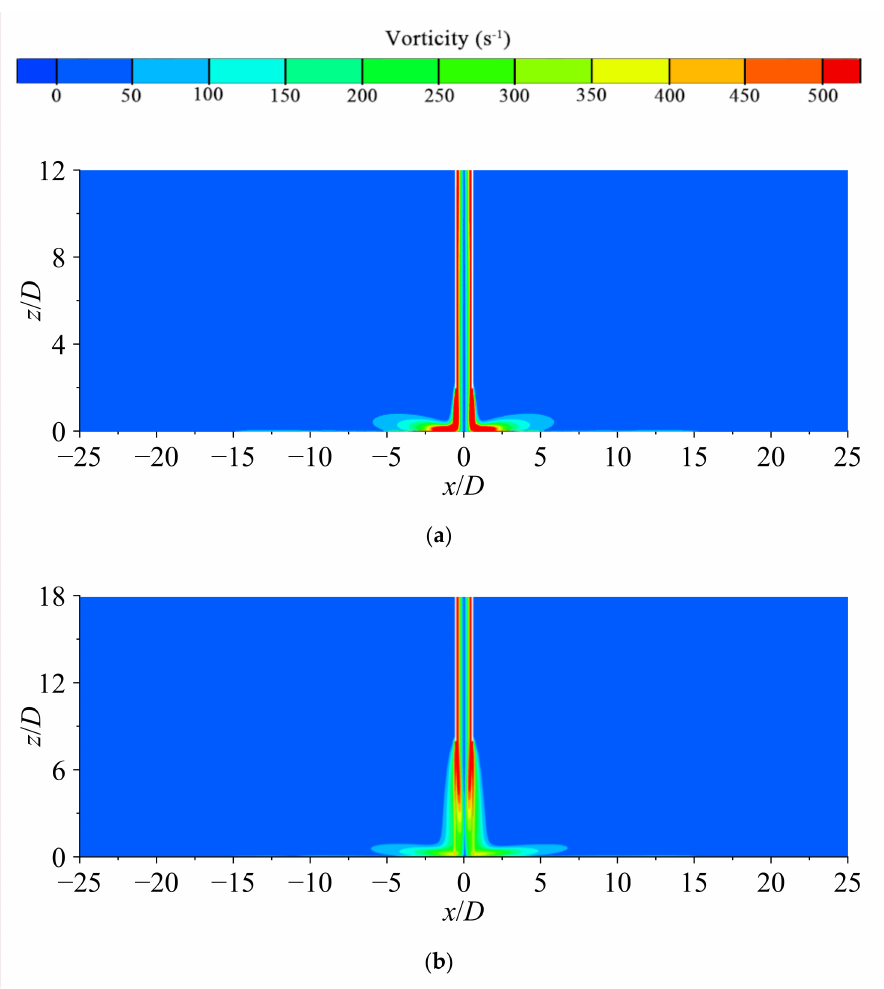
Figure 13. Cross-sectional vorticity diagram in the flow field at different H/D : ( a ) H/D = 2; ( b ) H/D = 8. Figure 14a,b show the dimensionless velocity V/V j distribution on the jet axis under conditions of different Reynolds numbers, with impact height H/D = 6, and different impact heights, with Reynolds number Re = 35,100. It can be seen from Figure 14a that the distribution of the dimensionless velocity V/V j on the jet axis at different Reynolds numbers almost coincides. This shows that the velocity distribution on the axis is independent of the Reynolds number. It can be seen from Figure 14b that the velocity on the central axis of the jet in the core area remains almost unchanged, and as the impact height increases, the core area gradually increases; the jet velocity decreases rapidly on the centerline of the impact zone, and when it reaches the wall surface, the dimensionless velocity V/V j decreases to 0, and the height of the impact zone is about 1 D . When H/D ≥ 6, the jet has a transition zone, and the jet’s velocity attenuates before reaching the impact zone; as the impact height increases, the transition zone gradually increases, the linear loss gradually increases, and the velocity of the fluid gradually decreases when the fluid reaches the impact zone. After comparing the numerical calculation results with the PIV experiment results at different impact heights, it is found that in the impact zone (0 ≤ z/D ≤ 1), the velocity distribution on the jet center axis is basically the same; in the free-jet zone ( z/D ≥ 1), the velocity change trend on the jet center axis is the same, and there is a very small